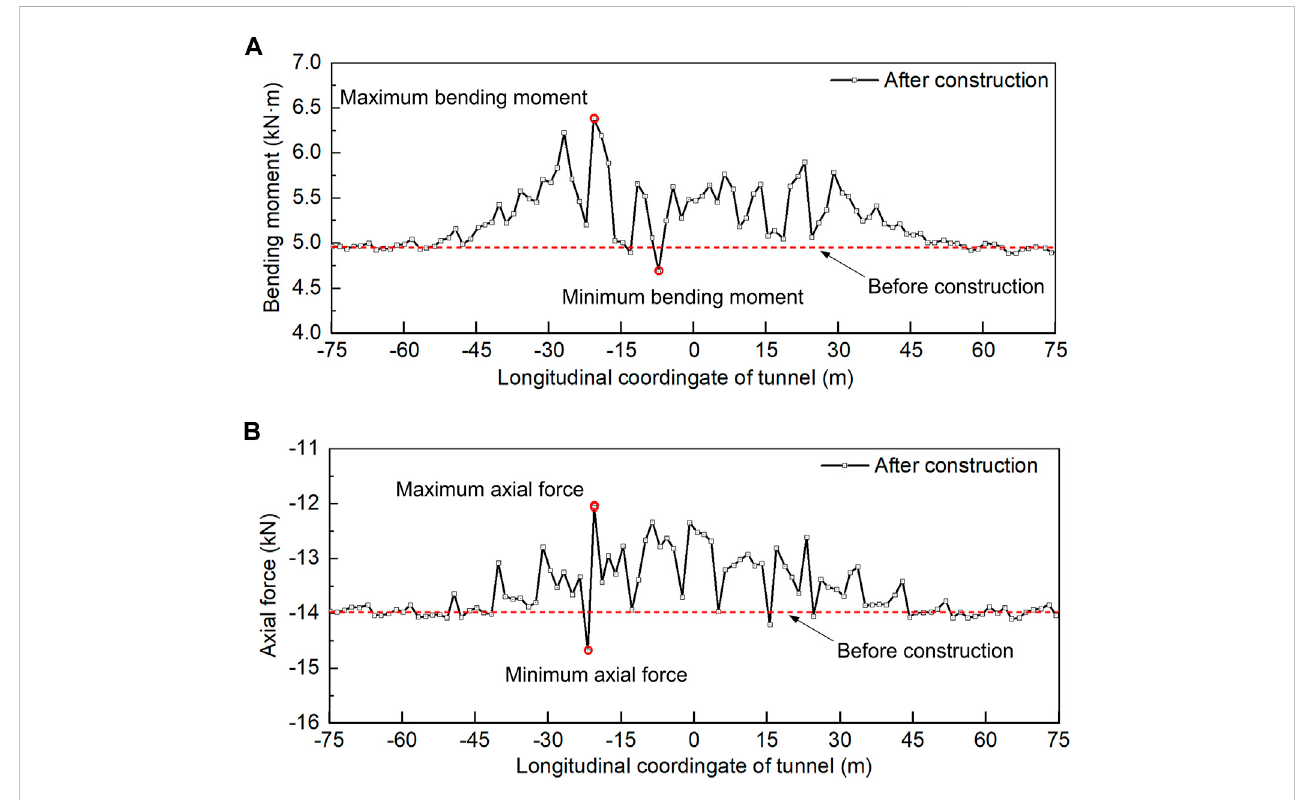
Variation curves of longitudinal internal force. (A) Bending moment. (B) Axial